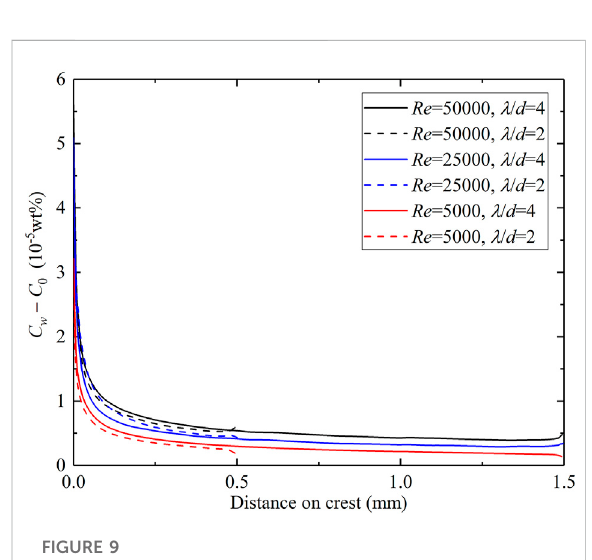
FIGURE 9 Distribution of ( C w − C 0 ) on the crest wall ( d = 500 μ m).